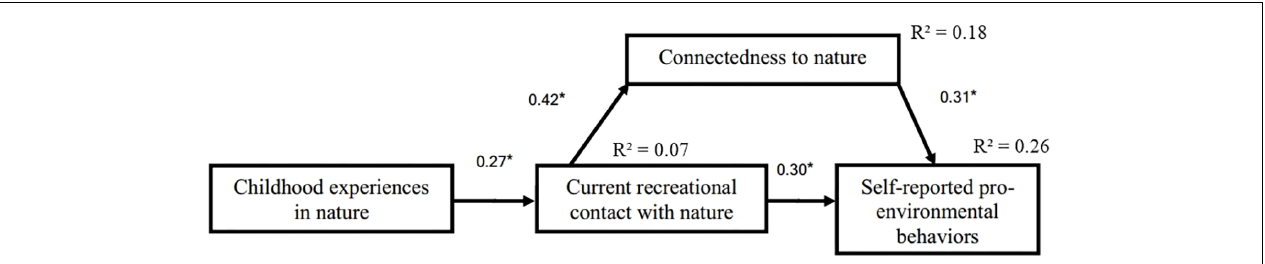
FIGURE 2 | Results for the path analysis. All regression coefficients are standardized. ∗ p <